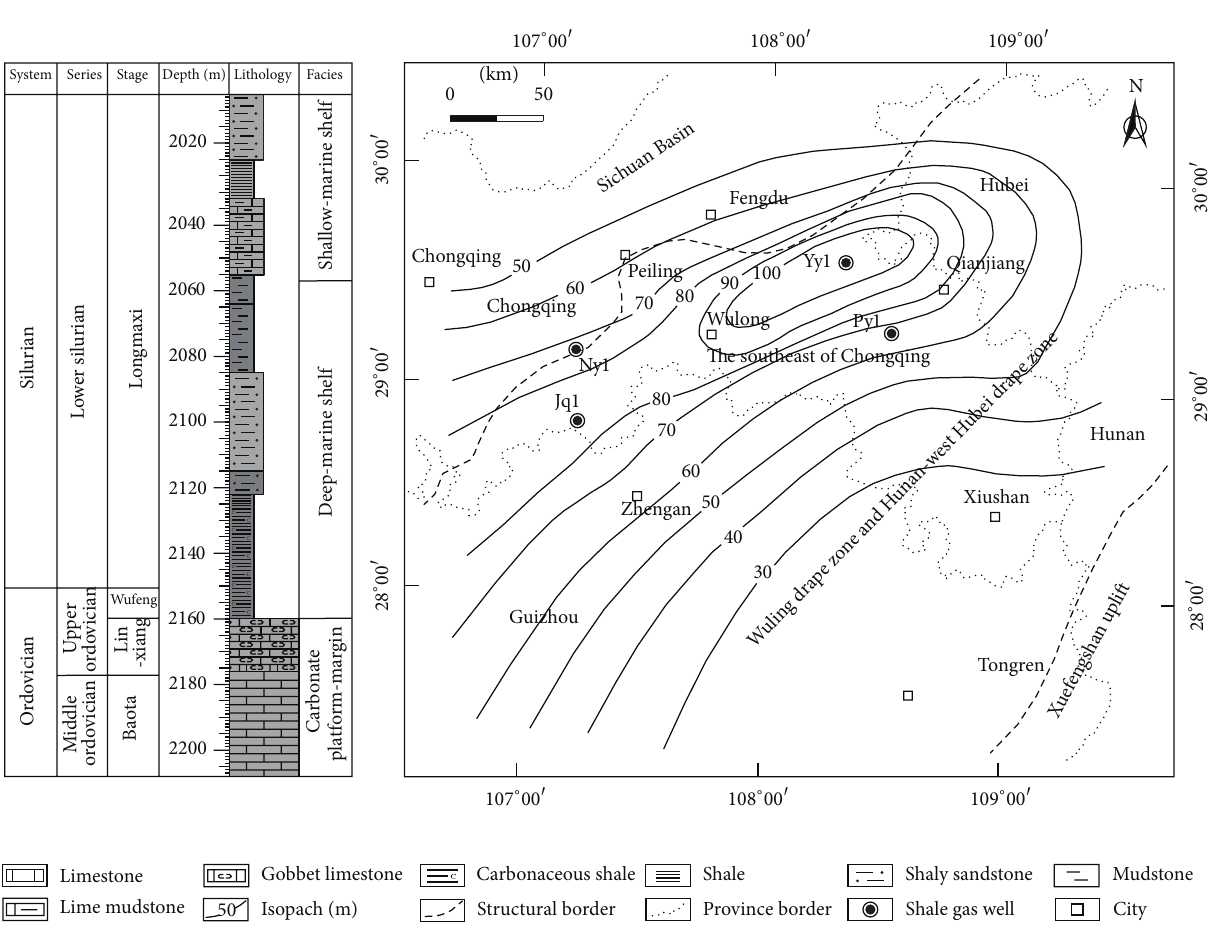
Figure 1: Stratigraphic column of Py1 well and isopach of Longmaxi Shale in southeast